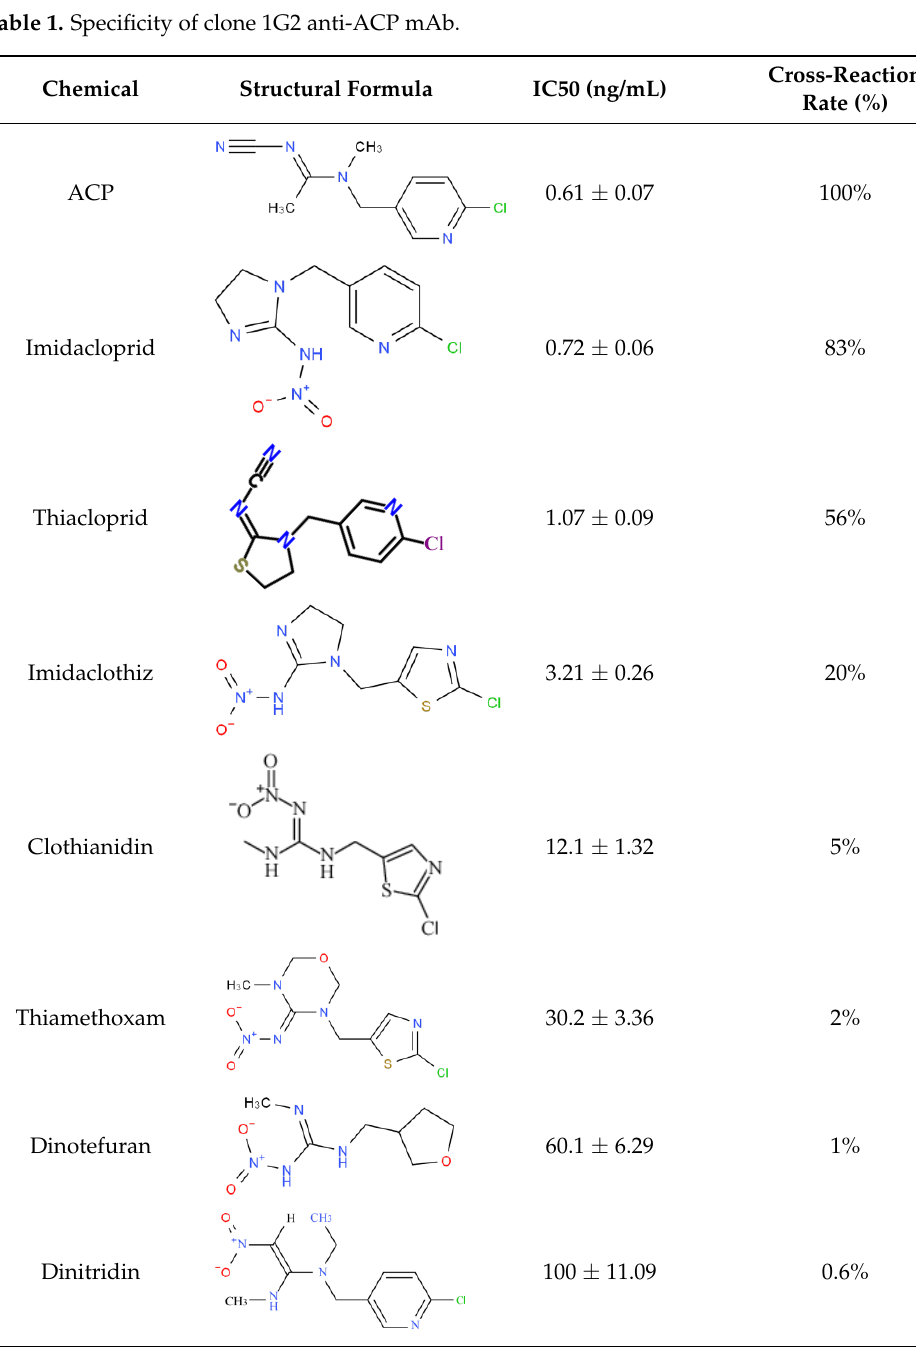
Table 2. ELISA results for specificity of anti-ACP mAb with each of the four coating agents. Coating Agent